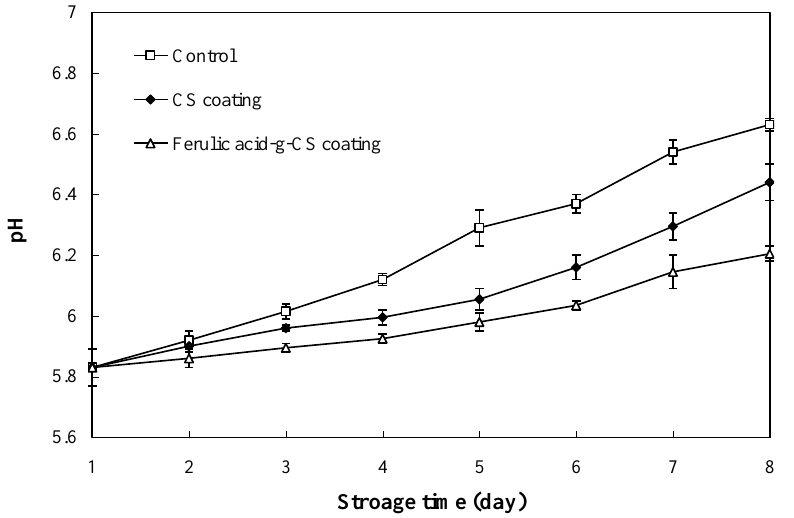
Figure 3. Changes in the pH value of pork in the control group, CS coating group and ferulic acid-g-CS coating group at 4 °C for 8 days. Data are presented as means ± SD of triplicates.